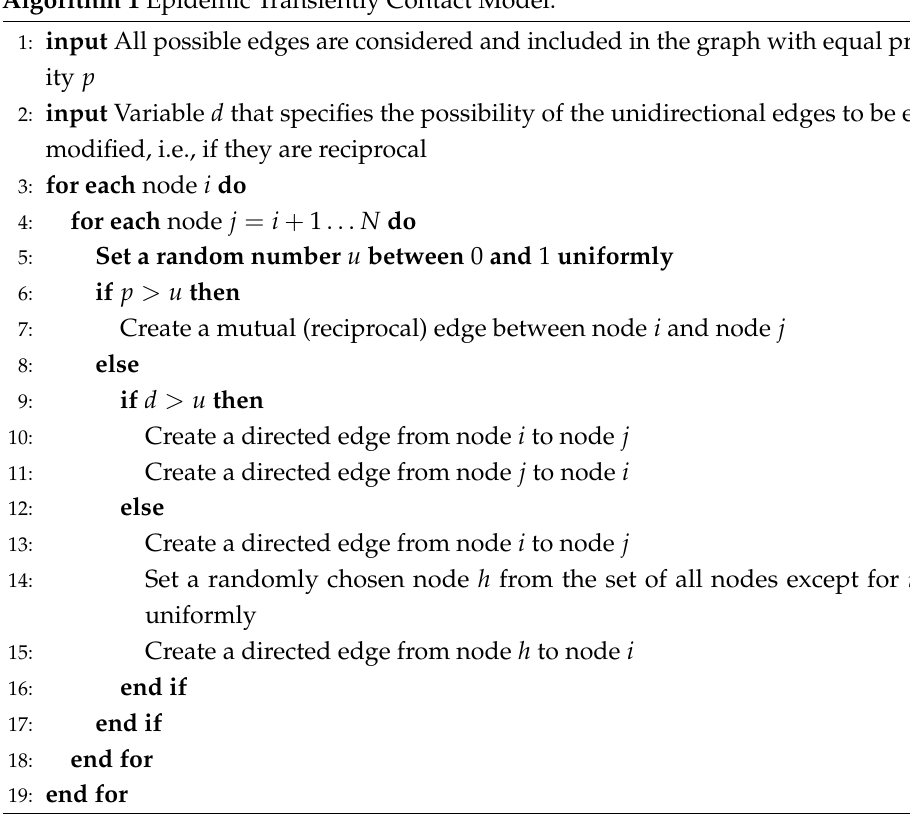
Algorithm 1 Epidemic Transiently Contact